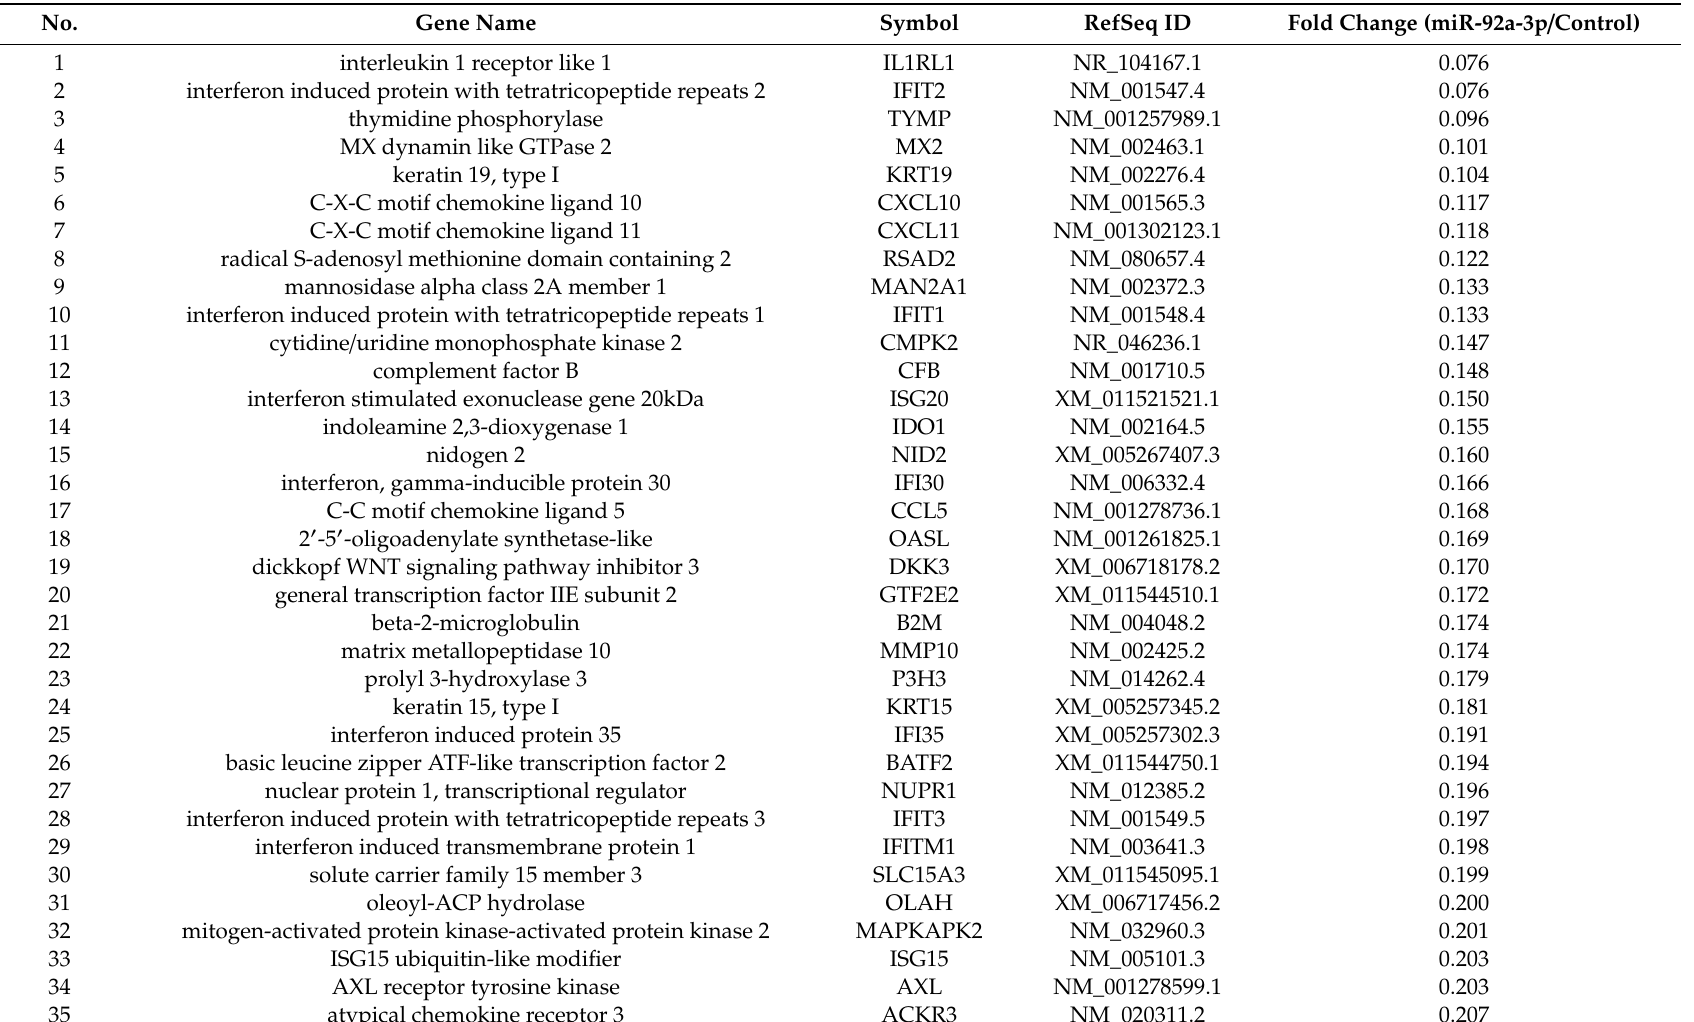
Table 2. More than a four-fold downregulation of DEGs in HUVECs transfected with